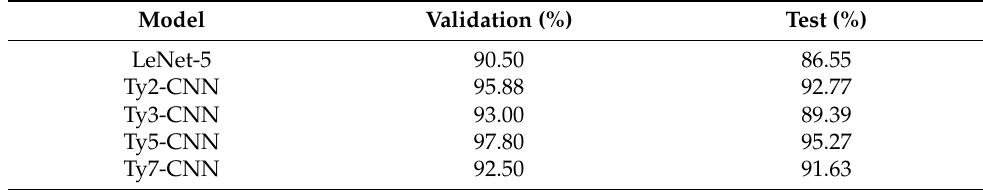
Table 2. Comparison of model accuracy with different kernel sizes.